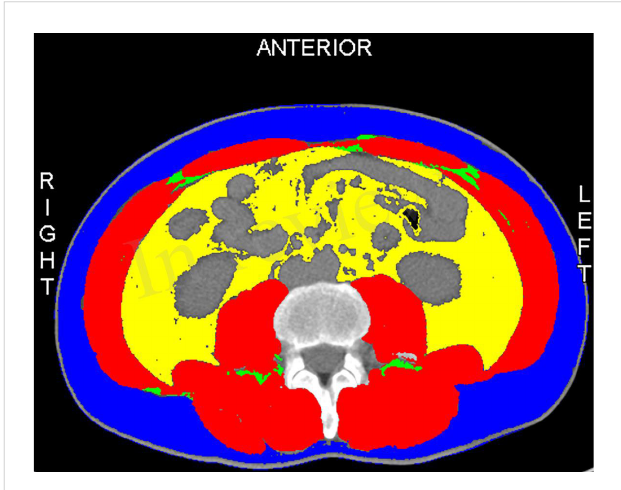
FIGURE 1 The skeletal muscles at the level of the third lumbar vertebra are painted in